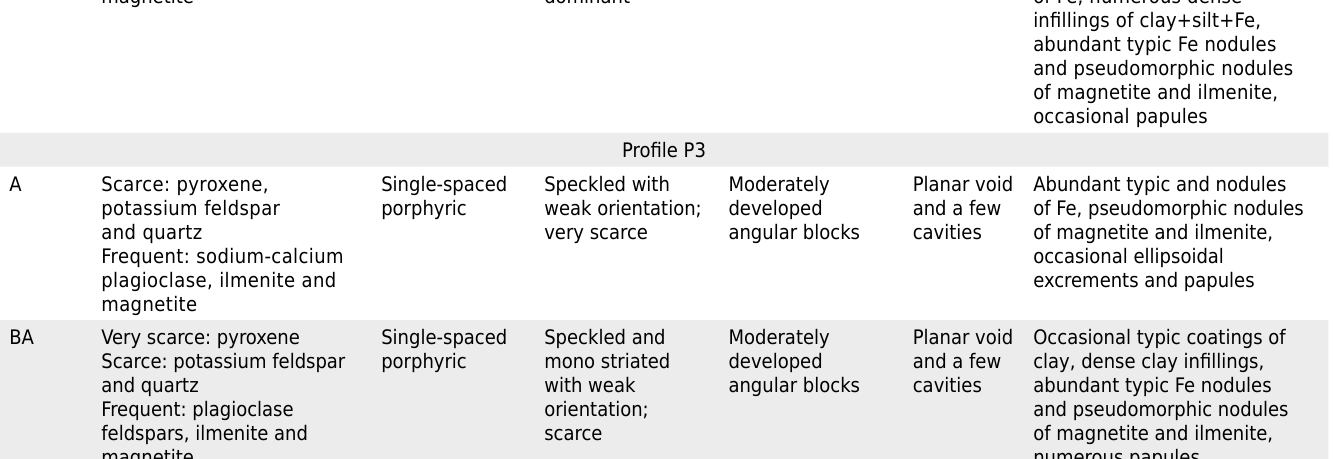
A2 Scarce: pyroxene, potassium feldspar and